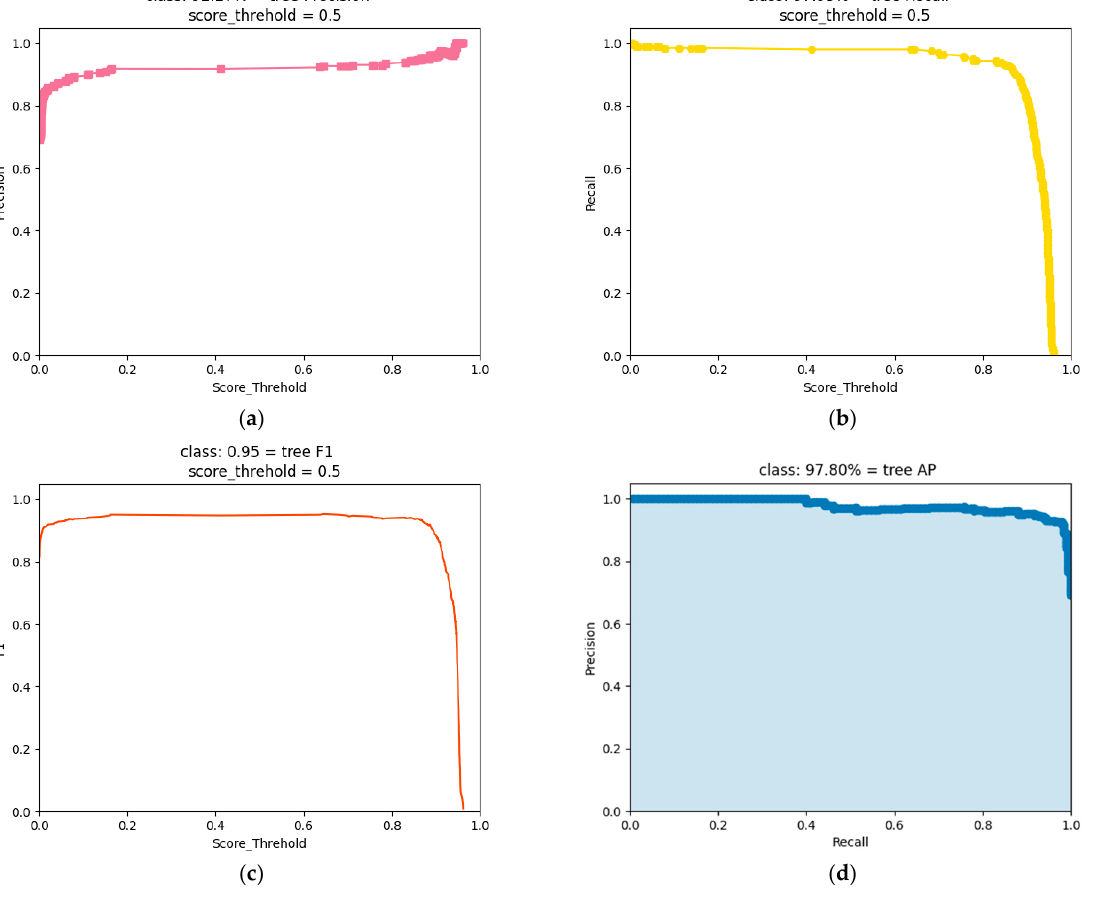
Figure 9. Evaluation results, which include P, R, F 1 , and AP. ( a ) P; ( b ) R; ( c ) F 1 ; ( d ) AP. From the detection indicators in Figure 9, it can be concluded that the prediction results of trees can meet the requirements of accurate detection of trees. The LOSS function curve of the training process is shown in Figure 10.